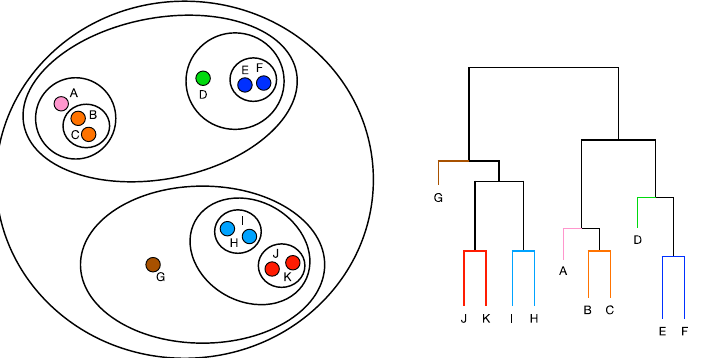
Figure 2. Procedure of hierarchical clustering techniques: the clustering begins with treating each lesion as a separate cluster and iteratively aggregates similar lesions, that is lesions with short pairwise distance, to merge groups of lesions in a single cluster. The output of the procedure is called a dendrogram.